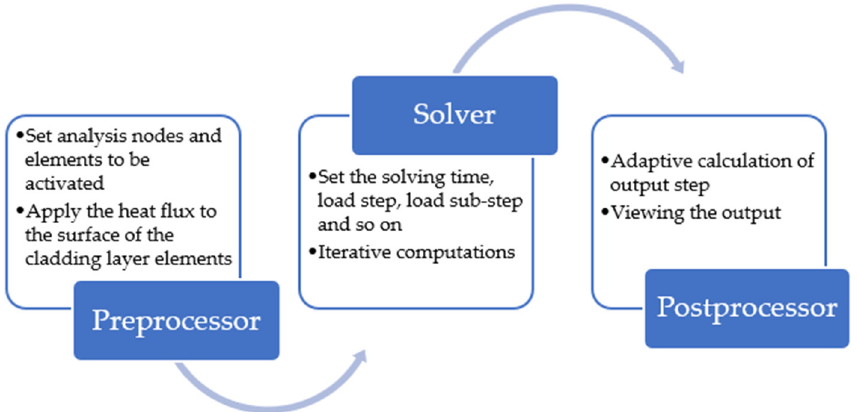
Figure 11. Finite element method for solving temperature field of thin-walled parts manufactured by AM.